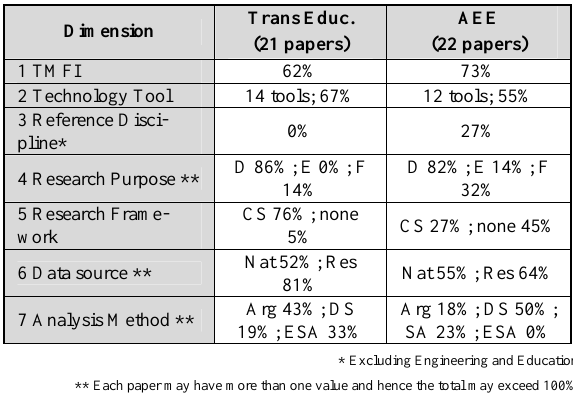
TABLE VI. S OURCES C ITED IN THE T WO J OURNALS IN 2011 AND C OMPARISON WITH P REVIOUS D ATA FOR THE IEEE T RANSACTIONS IN 2009